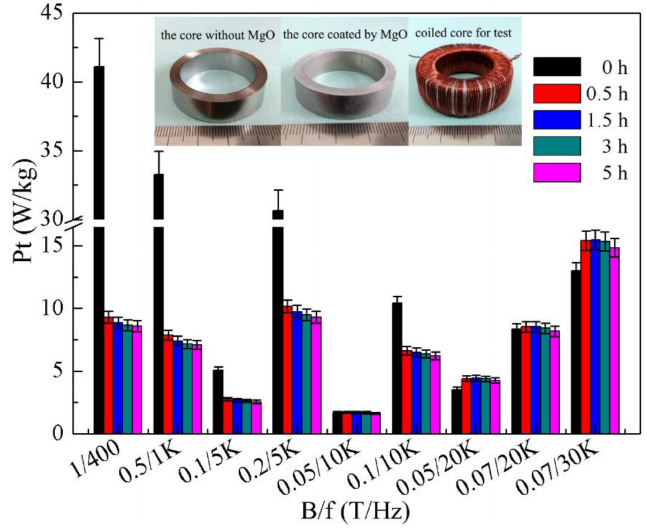
Figure 1. Iron losses corresponding to different conditions before after heat treatment; the inset represents the samples for